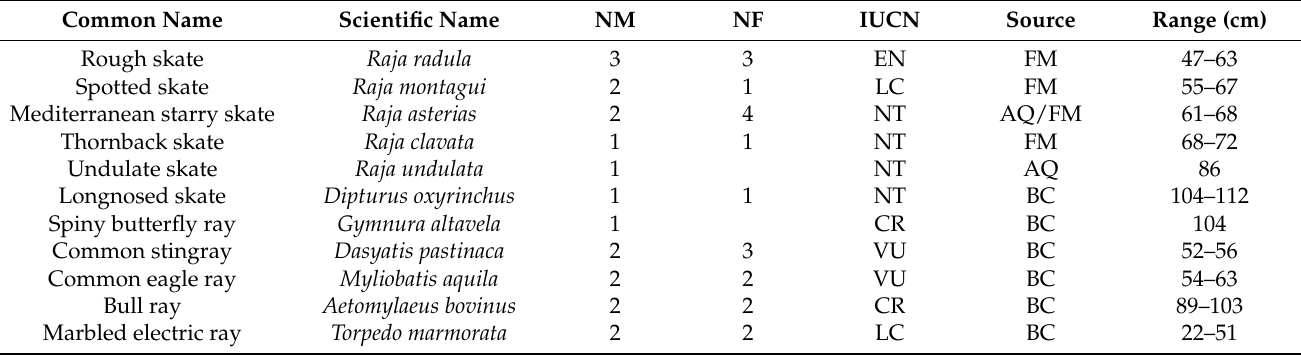
Table 1. Species in the study. Number of males (NM) and females (NF) from each species, size range of the specimens used and their origin and conservation status according to IUCN (International Union for Conservation of Nature) criteria for the Mediterranean [25]: least concern (LC), near threatened (NT), vulnerable (VU), endangered (EN) and critically endangered (CR). Animals from commercial fisheries were captured by gill net or bottom trawler and were available in fish markets (FM) or discarded as bycatch (BC). Animals from aquaria were part of the Oceanogr à fic zoological collection